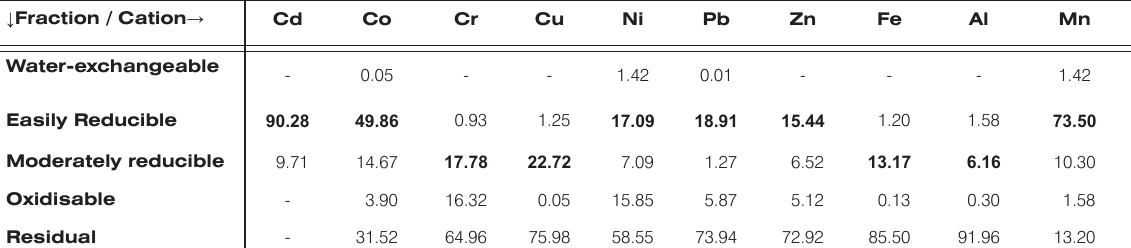
Table 2. The results obtained by sequential extraction procedure. Participation of different metals fractions in total metal content (%). ↓ Fraction / Cation